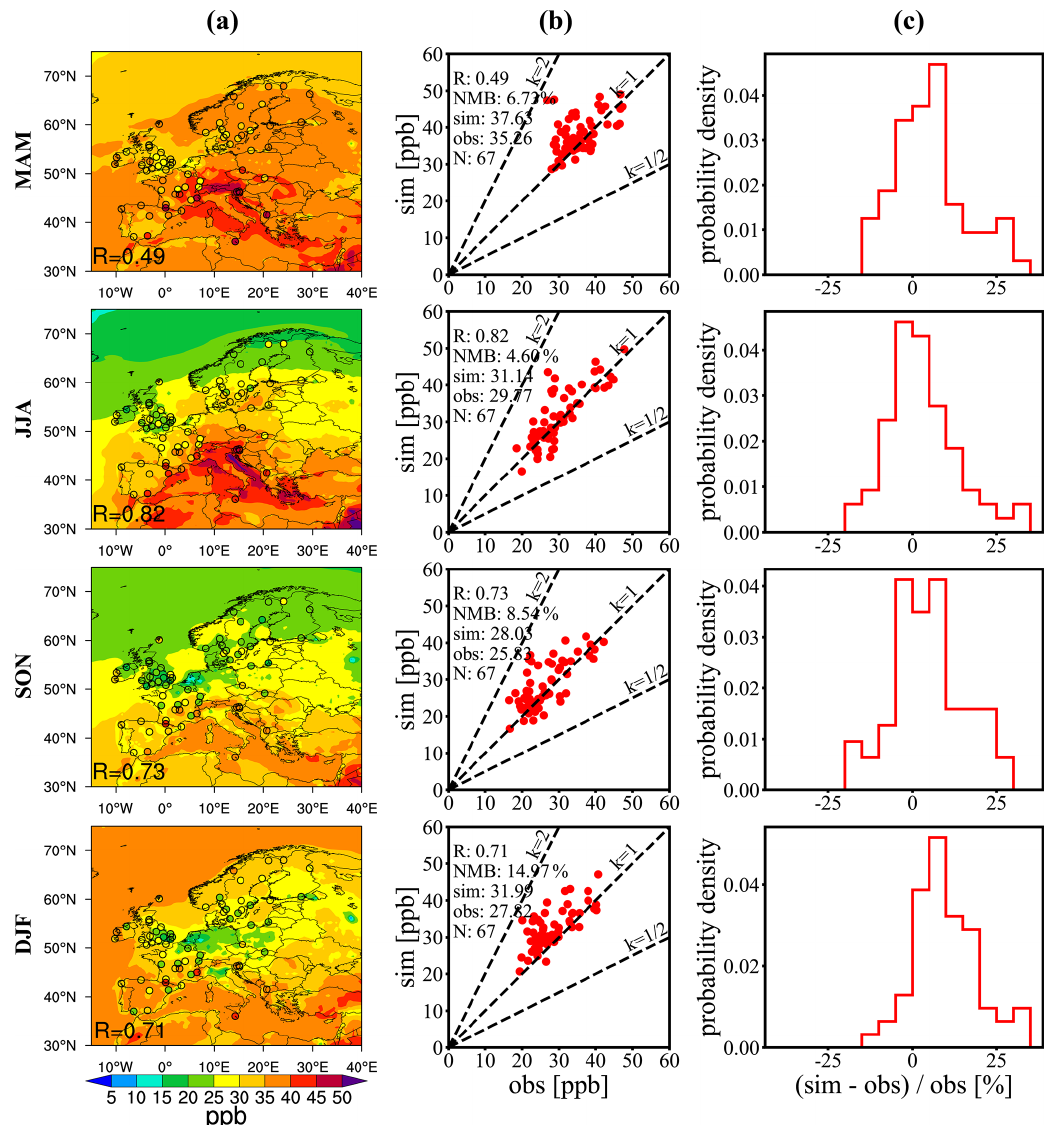
Figure 9. Same as Fig. 7 but in